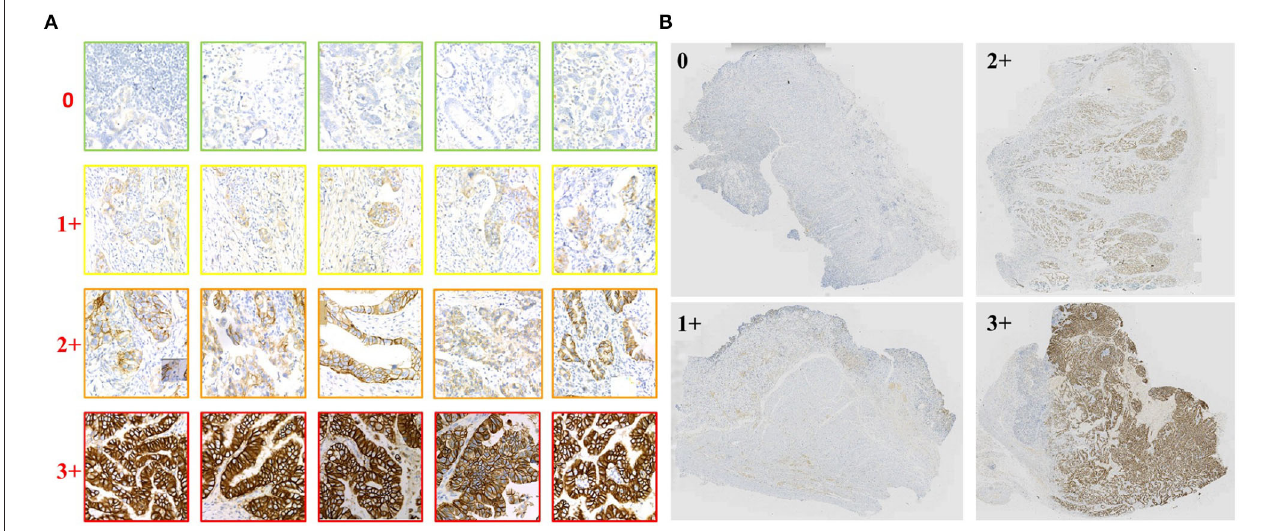
FIGURE 6 | Examples of data of Tile-level classification network (TLCN) and WSI-level HER2 score prediction network (WHSPN). (A) Samples of the TLCN dataset, which is composed of 256*256 pixels patches cropped from Whole slide images (WSIs). (B) Samples of the WHSPN dataset, which is consisted of WSI with billions of